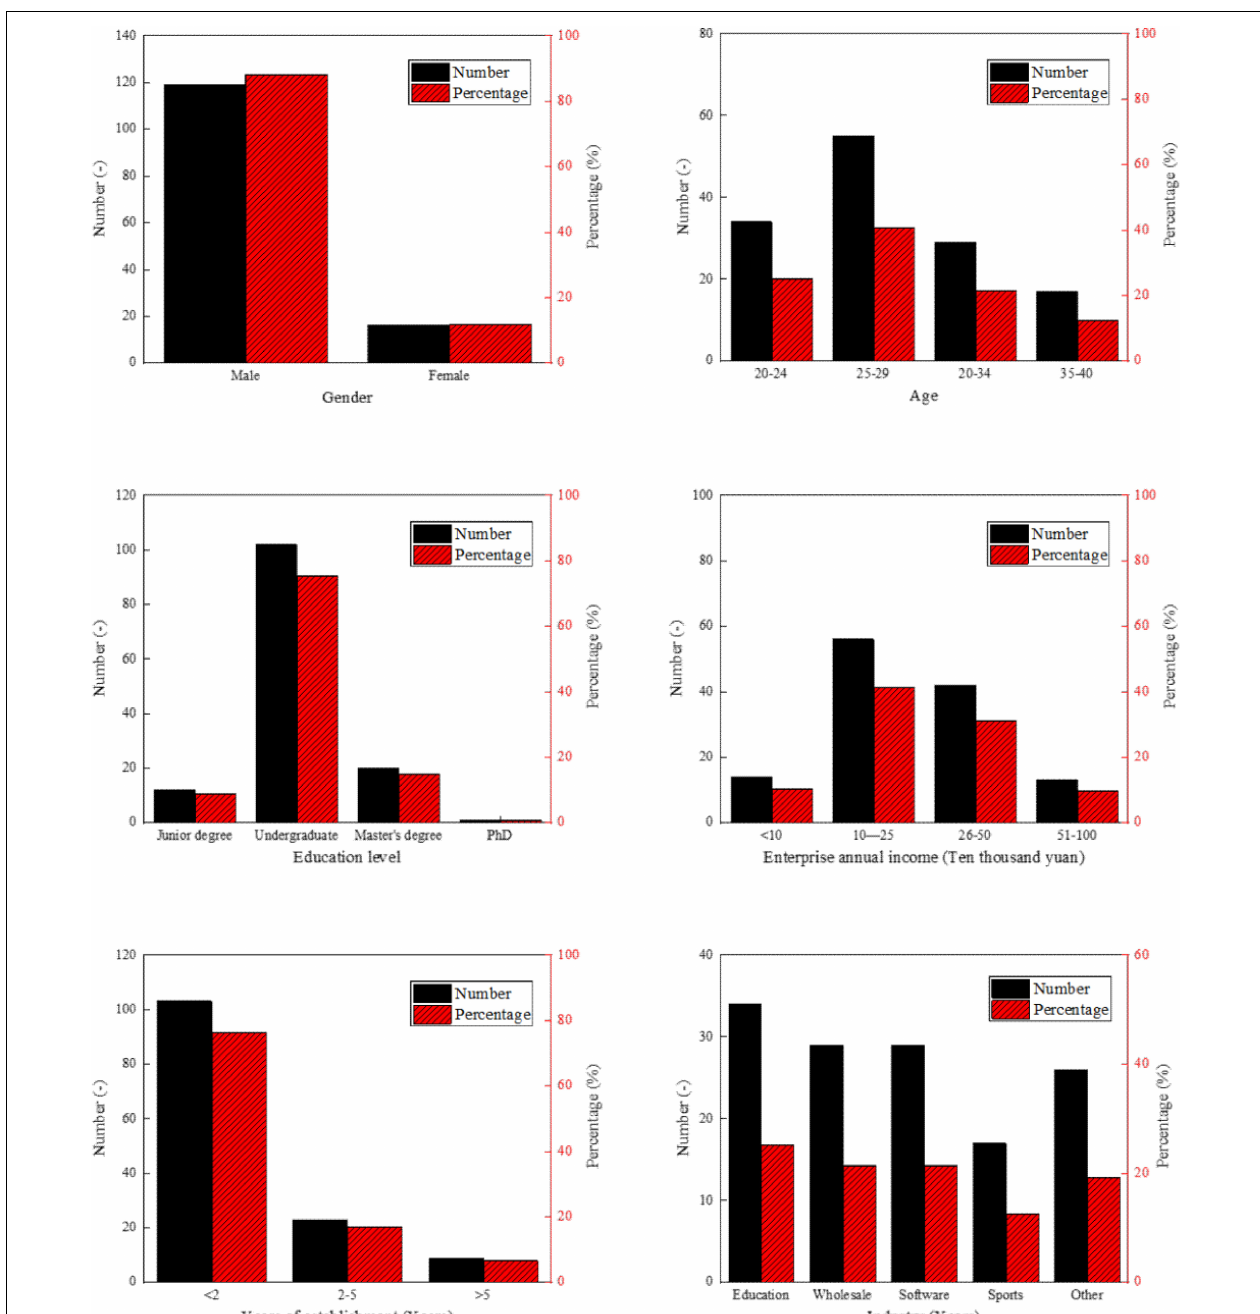
FIGURE 2 | Summary of basic information of research